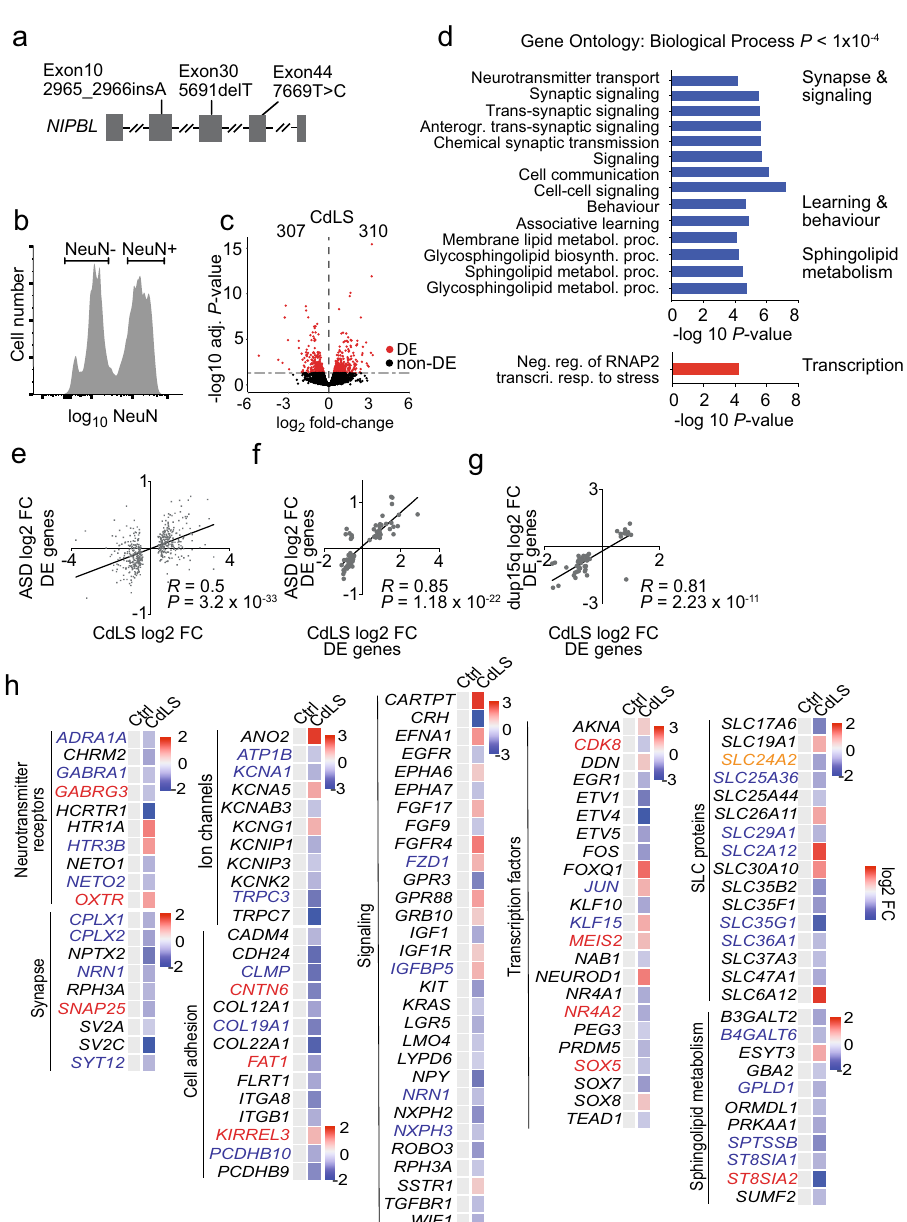
Fig. 1 CdLS patient brains display abnormal neuronal gene expression. a NIPBL mutations in CdLS patients. b Flow cytometry histogram of NeuN-stained nuclei from post-mortem tissue. Sort gates for NeuN-positive and -negative nuclei are indicated. c Volcano plot of gene expression fold-change versus adjusted P value of NeuN-positive nuclei from CdLS patients ( n = 4). 307 genes were down- and 310 genes were upregulated (RUVg k = 2, adj. P < 0.05, Wald Test, Benjamini-Hochberg adjusted). Differentially expressed (DE) genes are shown in red. d Bar graph of individual GO terms and broad categories ( P < 1 × 10 − 4 , Wallenius approximation). Terms represented by downregulated genes are shown in blue, those by upregulated genes in red. e Scatter plot of gene expression comparing log 2 fold-change of differentially expressed genes (adj P < 0.05) in idiopathic ASD, and the same genes in NeuN-positive CdLS samples. ( R = Pearson correlation coef fi cient; P = 3.2e-33, two-sided F test). f Scatter plot of log 2 fold-change of shared deregulated genes (adj P < 0.05) in both ASD and NeuN-positive CdLS samples. ( R = Pearson correlation coef fi cient; P = 1.18e-22, two-sided F test). g Scatter plot of log 2 fold-change of genes that were deregulated in both duplication of chromosome 15q.11.2-13.1 (dup15q) and NeuN-positive CdLS samples. ( R = Pearson correlation coef fi cient; P = 2.23e-11, two-sided F test). h Heatmap of log 2 fold-changes for deregulated genes in NeuN-positive CdLS samples. Genes are grouped by functional categories. Genes highlighted in red are in the SFARI database 41 , those in blue were deregulated in ASD and/or dup15q, genes highlighted in orange meet both